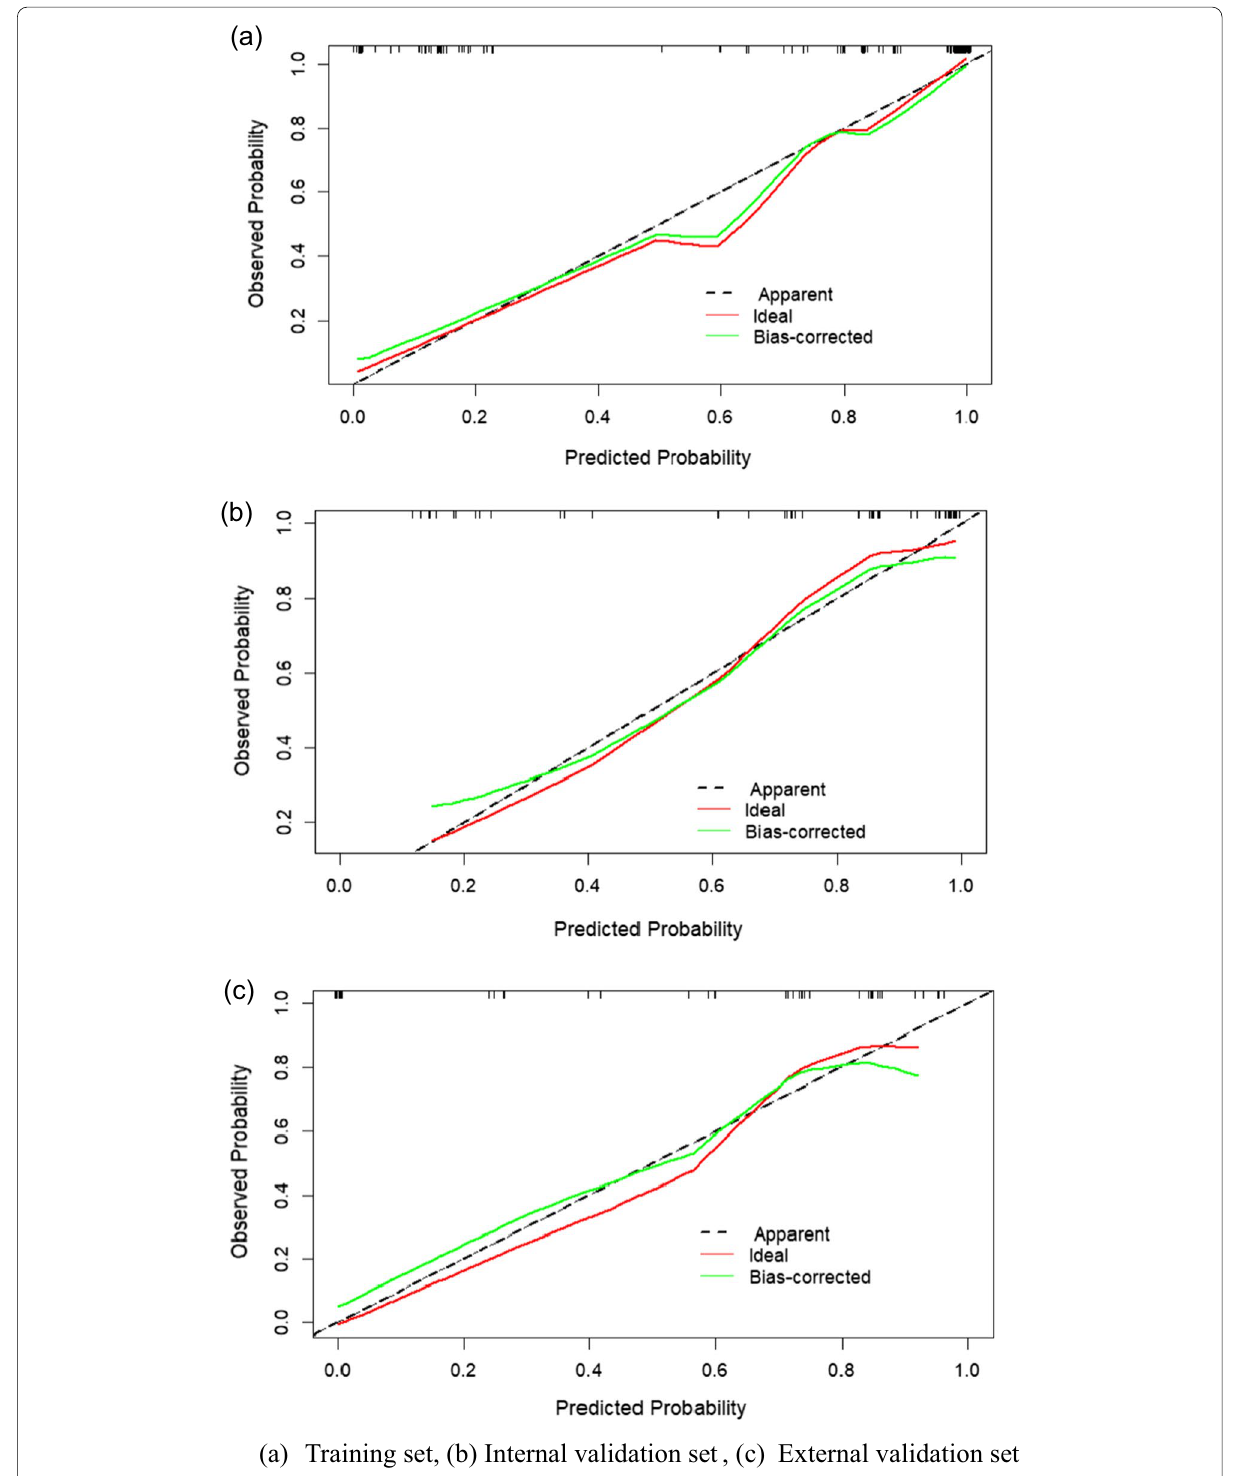
Fig. 5 Calibration curve for predicting probability of